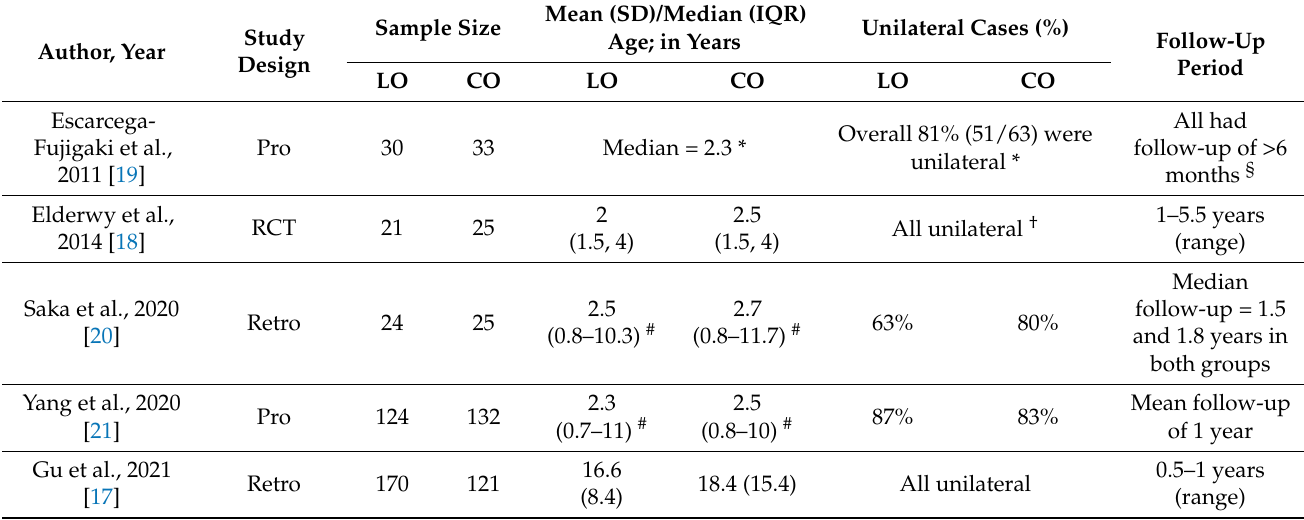
Table 1. Characteristics of the included studies.